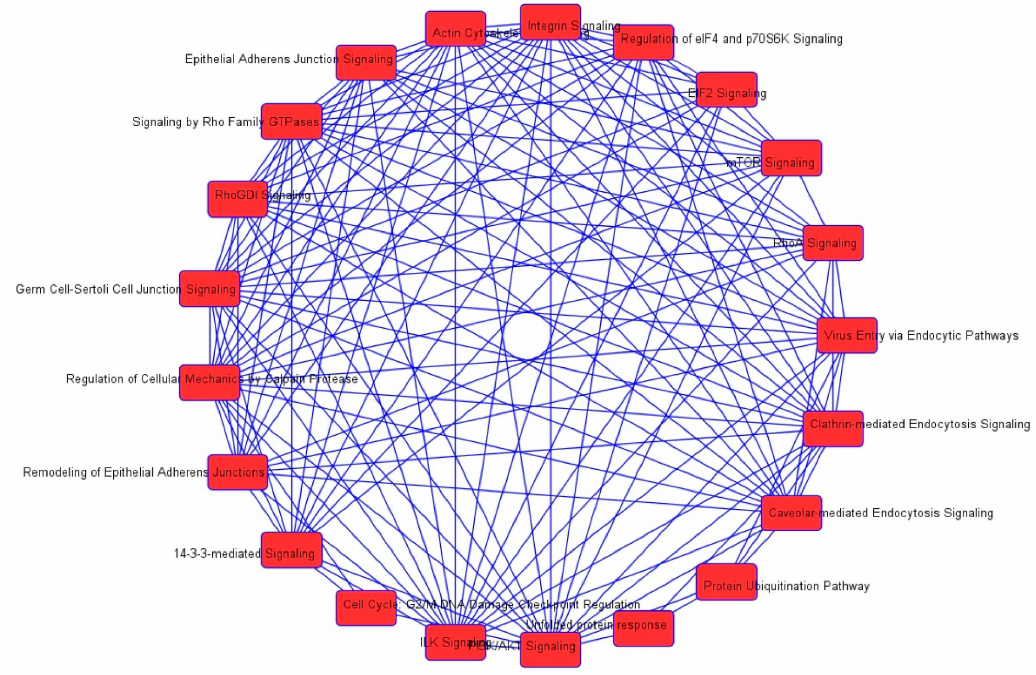
Figure 2. Intergrated signaling pathways regulated by vancomycin in HK-2 cells.